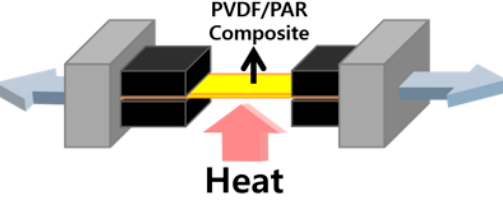
Figure 3. Schematics of PVDF/PAR composite drawing process.